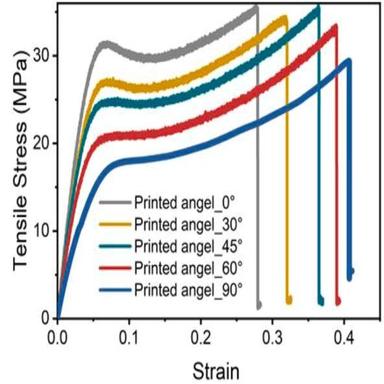
True stress-strain curves for cylindrical tensile specimens printed at different printing angles.